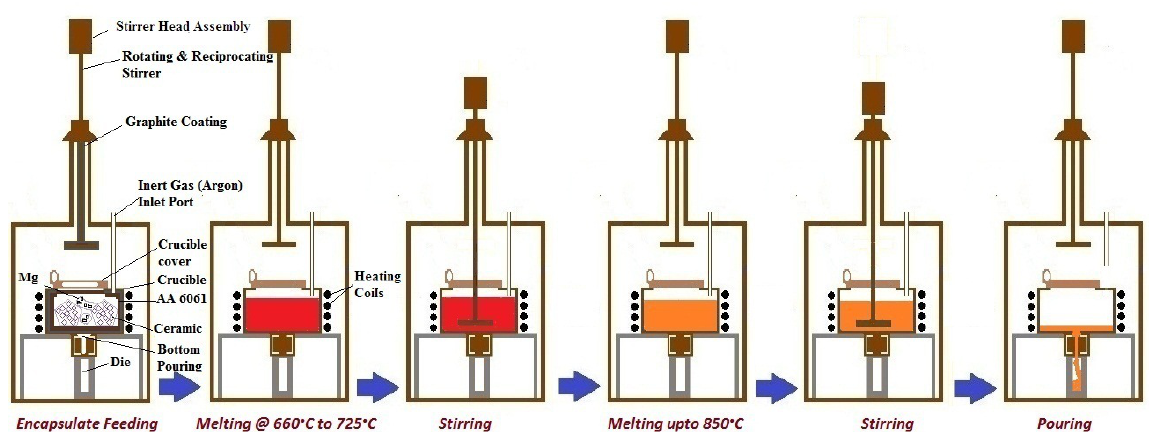
Figure 1: Schematic Representation of Sequential process in combined Feeding